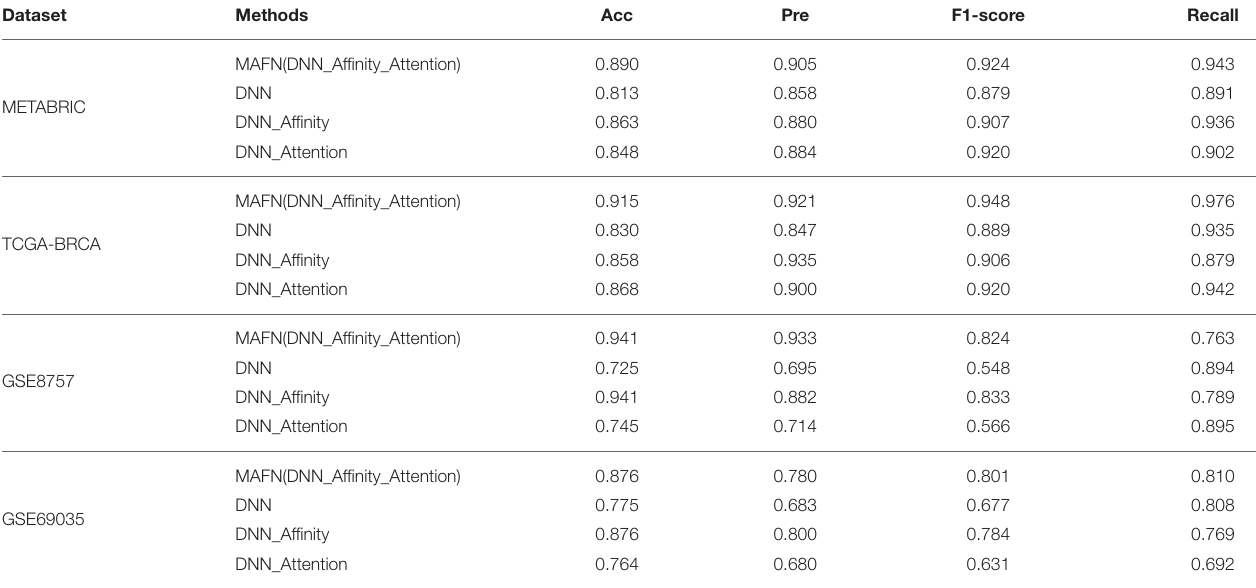
TABLE 3 | Acc, Pre, F1-score, and Recall predictive performance metrics of multimodal affinity fusion network (MAFN) and single-module models.